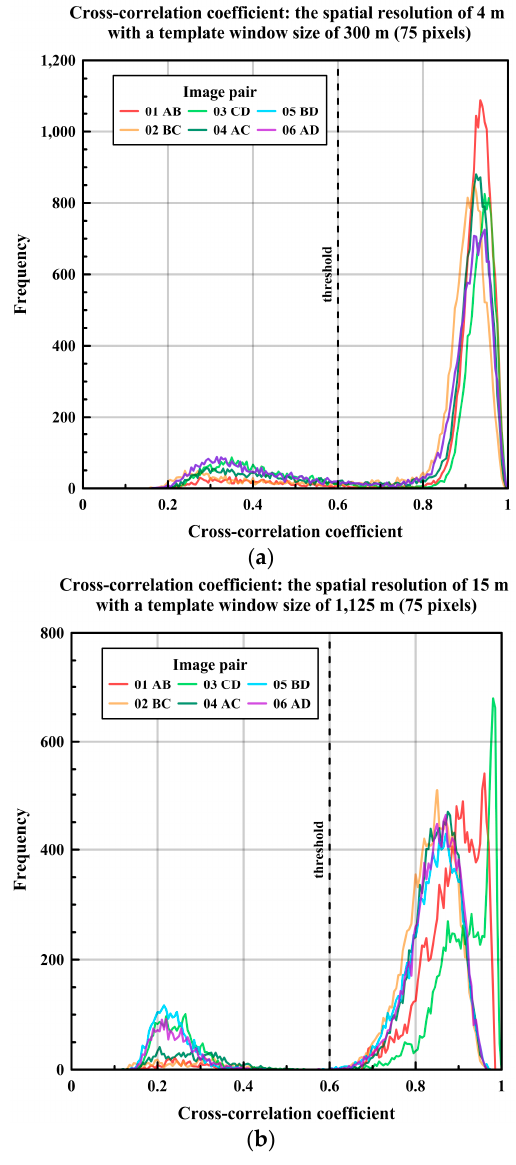
Figure 4. The histogram of the cross-correlation coefficient: ( a ) the image pairs of the spatial resolution of 4 m; and ( b ) the image pairs of the spatial resolution of 15 m.